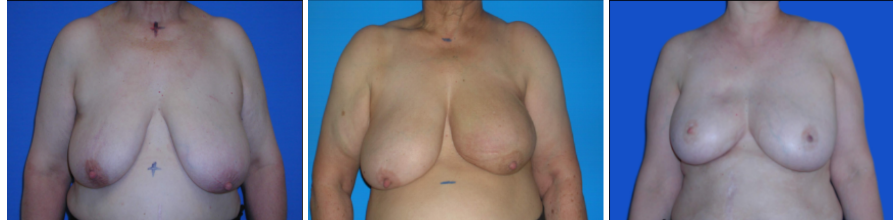
Figure 7. Examples of Images from the BCCT core dataset.